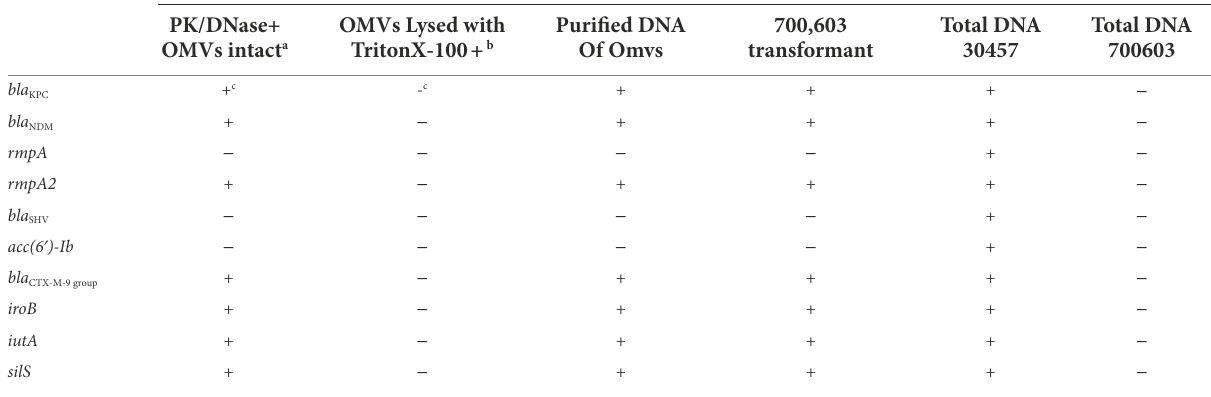
TABLE 2 Presence of antibiotic resistance and virulence genes in OMVs of NUHL30457 strain and 700,603 transformant.